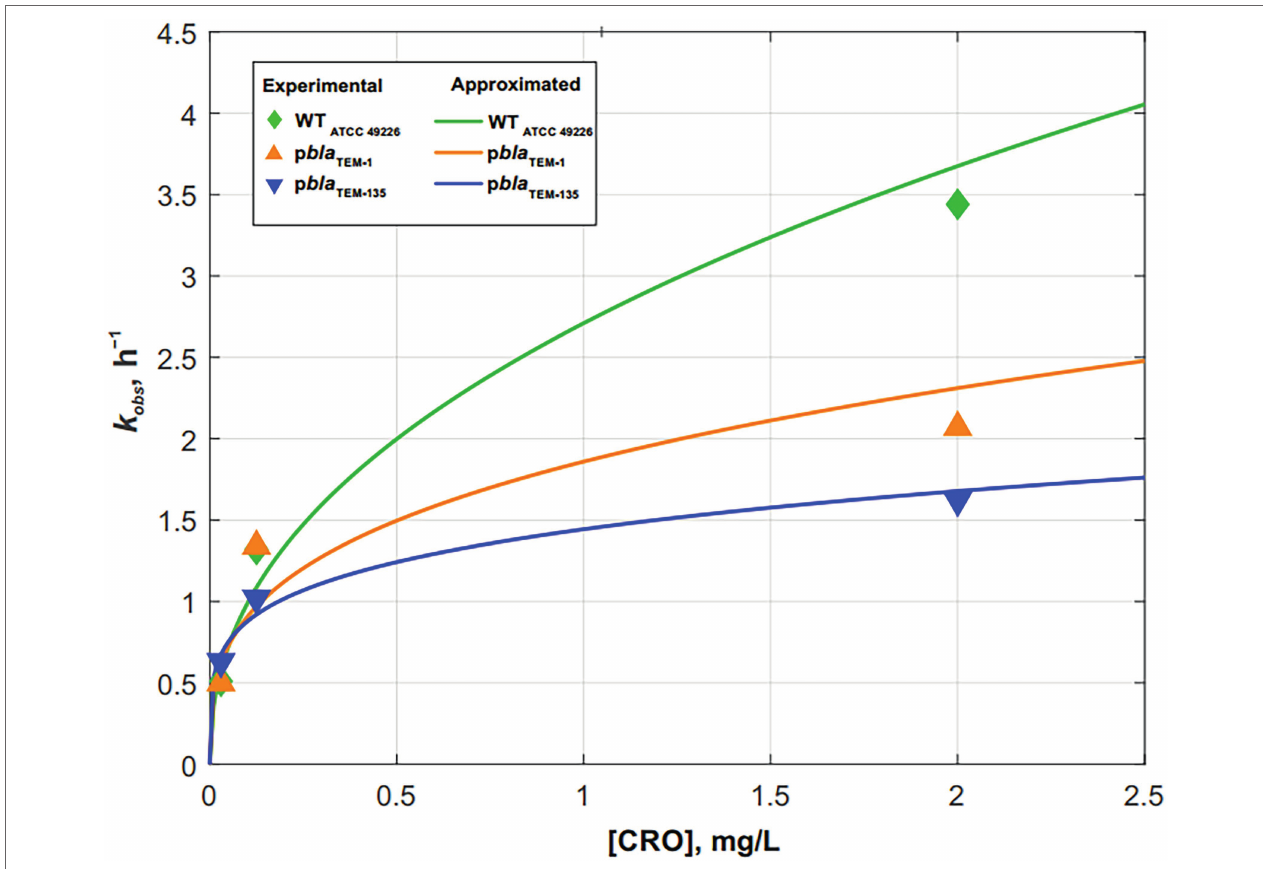
FIGURE 4 | Dependence of the cell death rate constant k obs on the ceftriaxone concentration for Neisseria gonorrhoeae strains not carrying the plasmids and carrying p bla TEM-1 and p bla TEM-135 . The solid lines show the power approximation curves constructed according to Eqs.